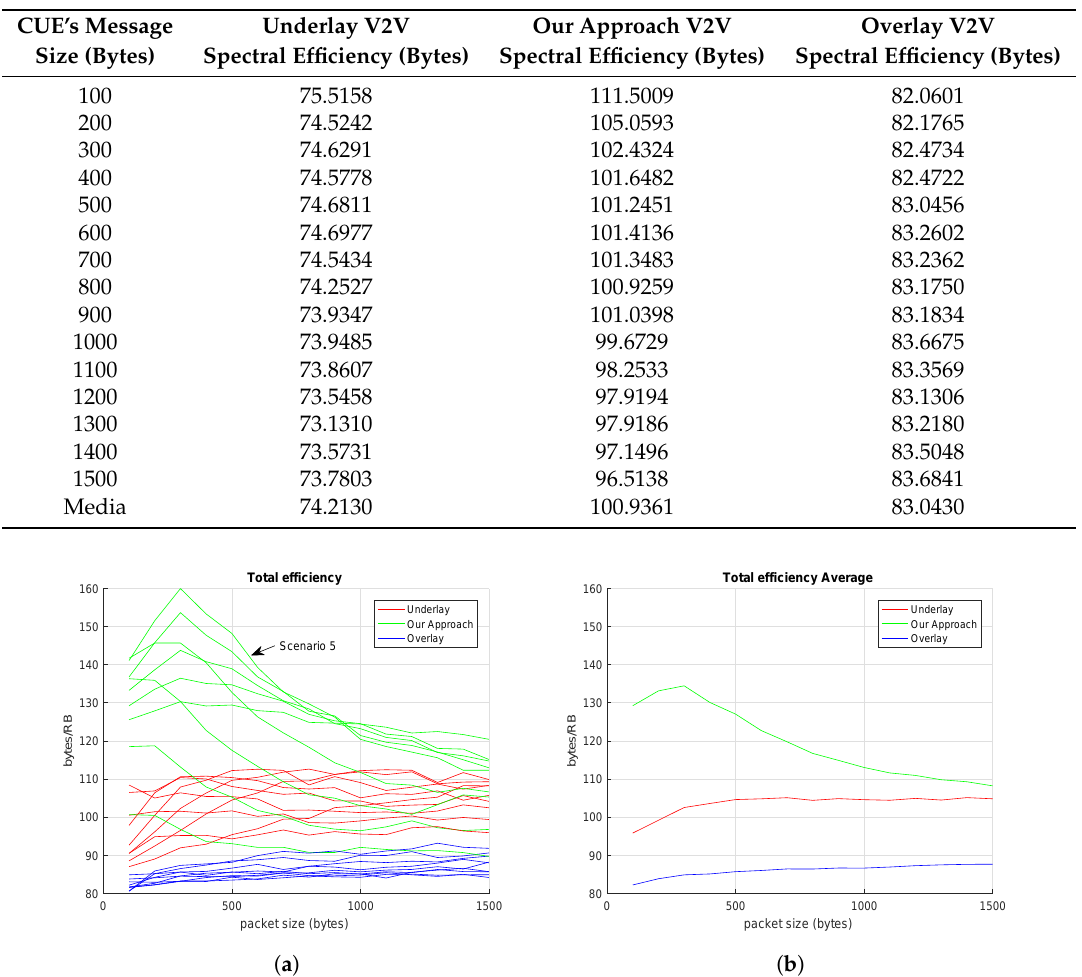
Table 5. Average Spectral Efficiency offered to V-UEs based on C-UEs’ traffic pattern.